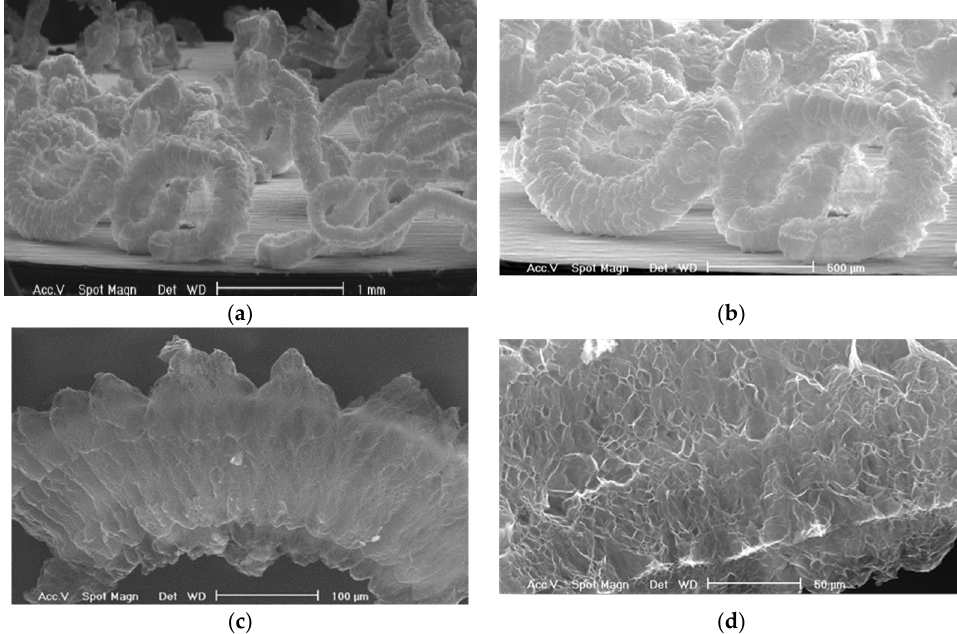
Figure 2. Characterization of the Grafysorber by Scanning Electron Microscopy (SEM) analysis at different magnifications ( a ) 1 mm; ( b ) 500 µm; ( c ) 100 µm; ( d ) 50 µm.